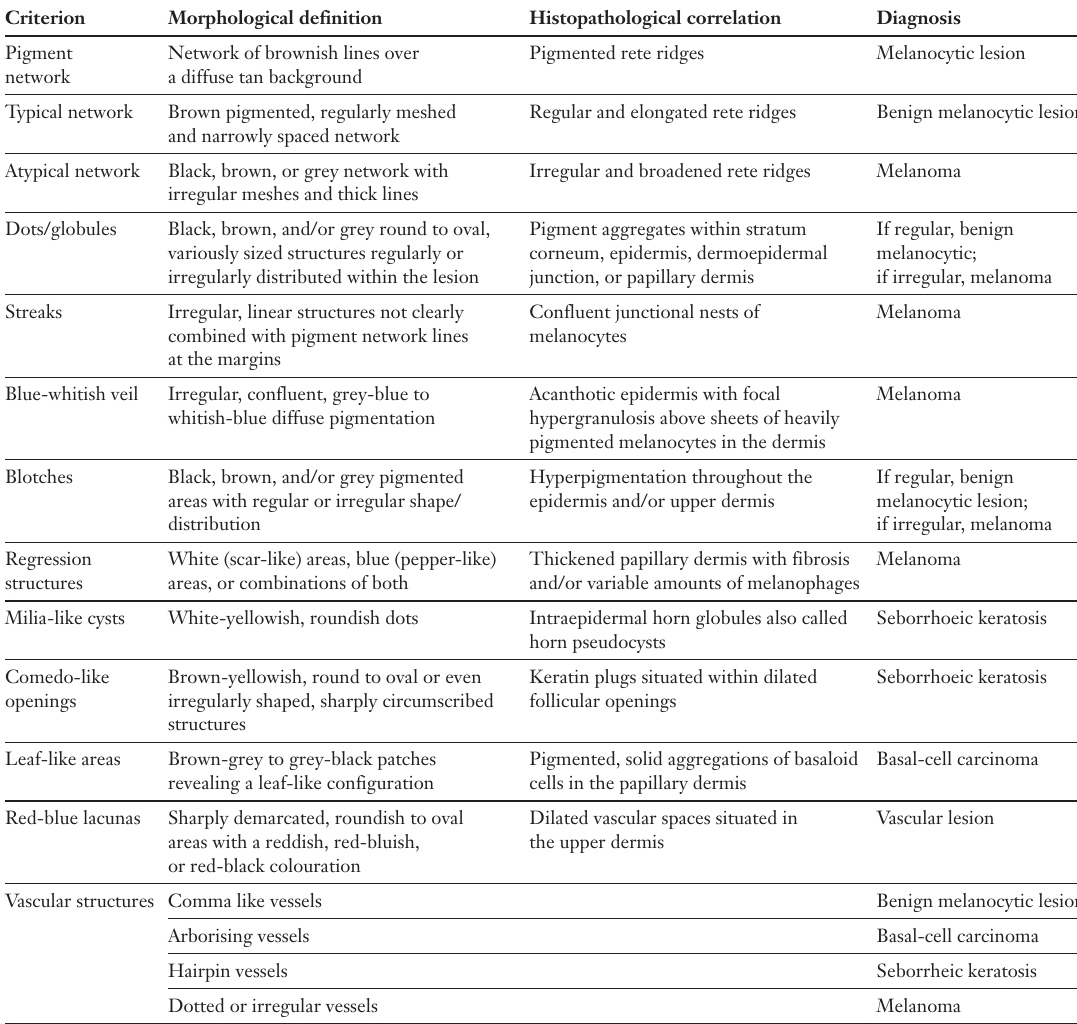
Provides an overview of the most important dermoscopy criteria, their definition and their histopathological correlation according to Argenziano et al. [46]. Criterion Morphological